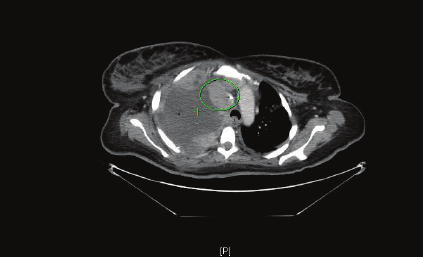
Figure 2: CT with contrast demonstrating near-complete supe- rior vena cava occlusion by tumor invasion/extrinsic mass e ff ect